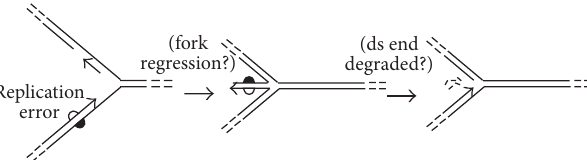
Figure 4: Repositioning of replication errors by fork reversal. If a replication fork reverses shortly after making a replication error, the resulting mismatch would be localized to the short (extruded) arm. In principle, this could provide a basis for removing replication errors without involving a conventional (MutSL-dependent) MMR system. The white semicircle represents a polymerase error; heavy lines depict parental (template)